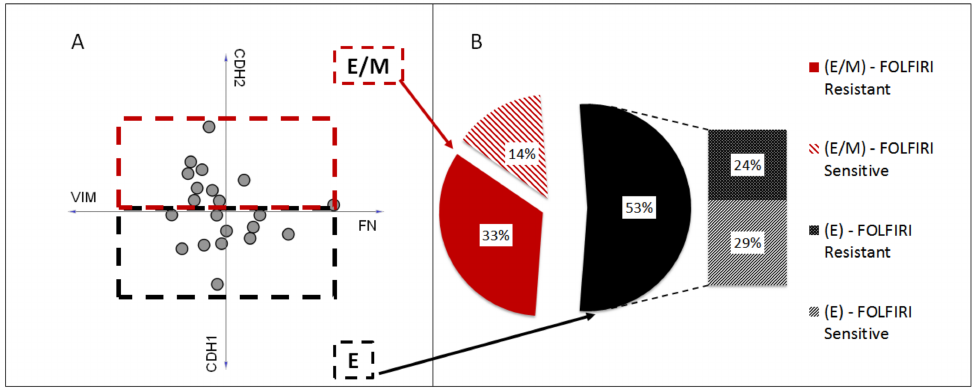
Figure 7. EMT phenotypes of FOLFIRI-resistant and -sensitive patients. Patient samples ( n = 21) from GSE62080 were attributed to two groups, strongly epithelial (E) and partially mesenchymal (E/M), based on the mRNA levels of four primary EMT markers, E-cadherin (CDH1), N-cadherin (CDH2), vimentin (VIM), and fibronectin (FN), using Orange software ( A ). Sample distribution among E and E/M groups ( B